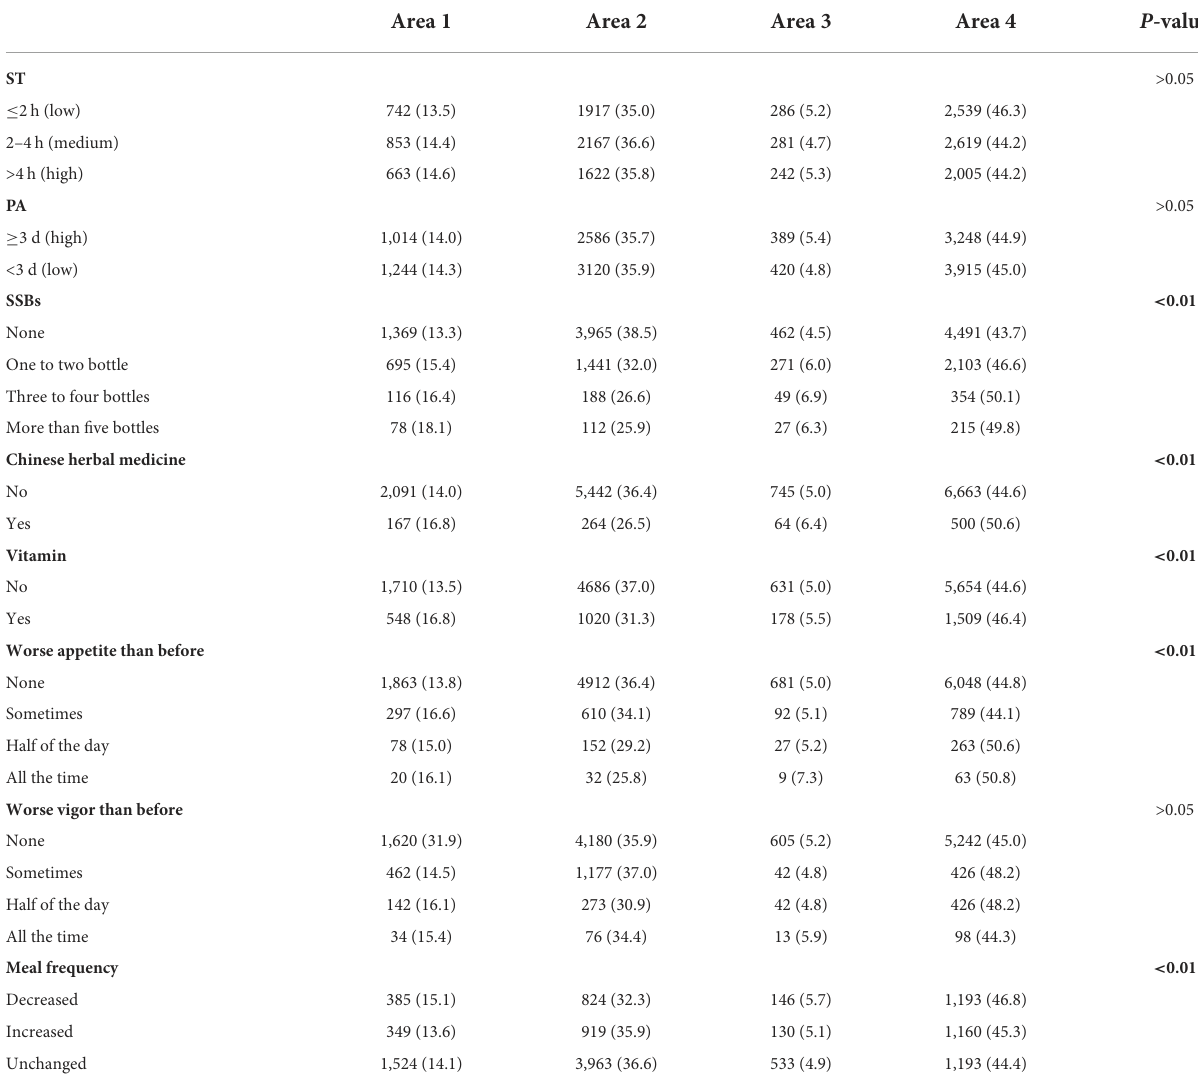
TABLE 3 The difference regional areas of health behaviors among college